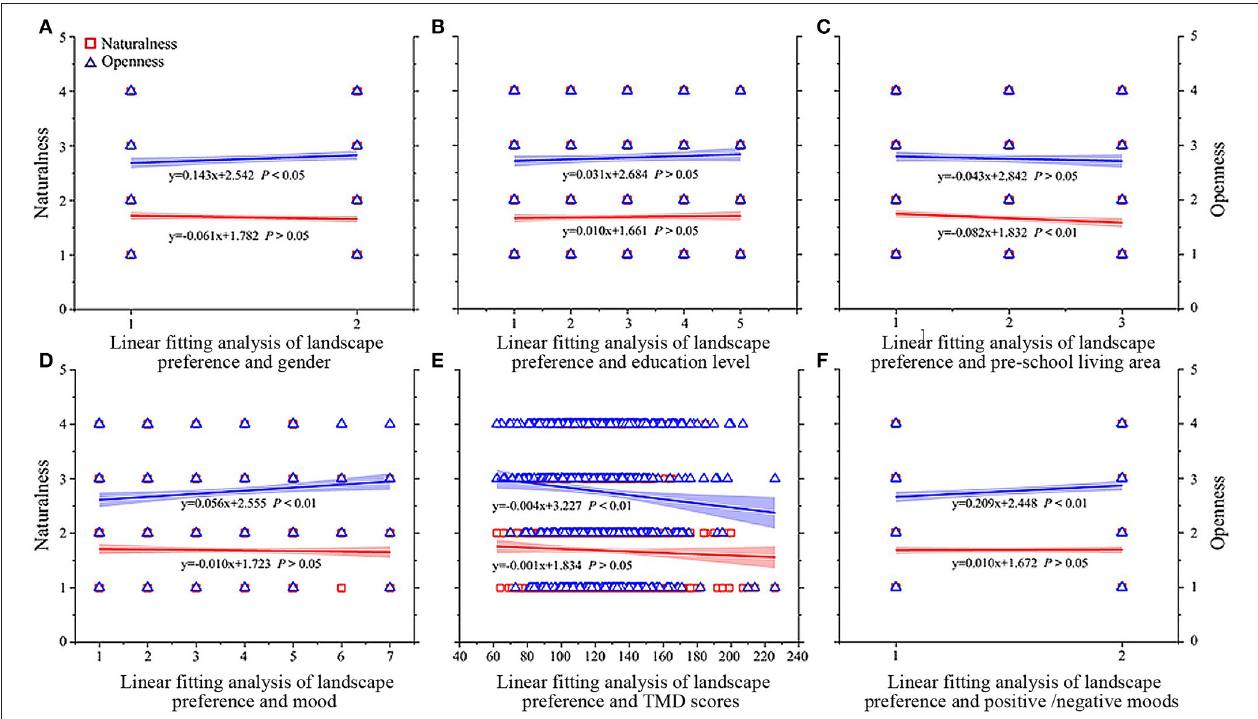
FIGURE 2 | Linear fitting analysis graph. Naturalness: 1, full naturalness; 2, most naturalness; 3, most artificial work; 4, full artificial work; Visual openness:1, closed; 2, semi-closed; 3, semi-open; 4, openness; Gender: 1, male; 2, female; Education level:1, first grade; 2, second grade; 3, third grade; 4, fourth grade; 5, above fourth grade; Preschool living area:1, city; 2, small town; 3, countryside; Mood:1, T-A; 2, A-H; 3, D; 4, F; 5, V; 6, C; 7, E; Positive and negative moods: 1, negative moods; 2, positive moods.